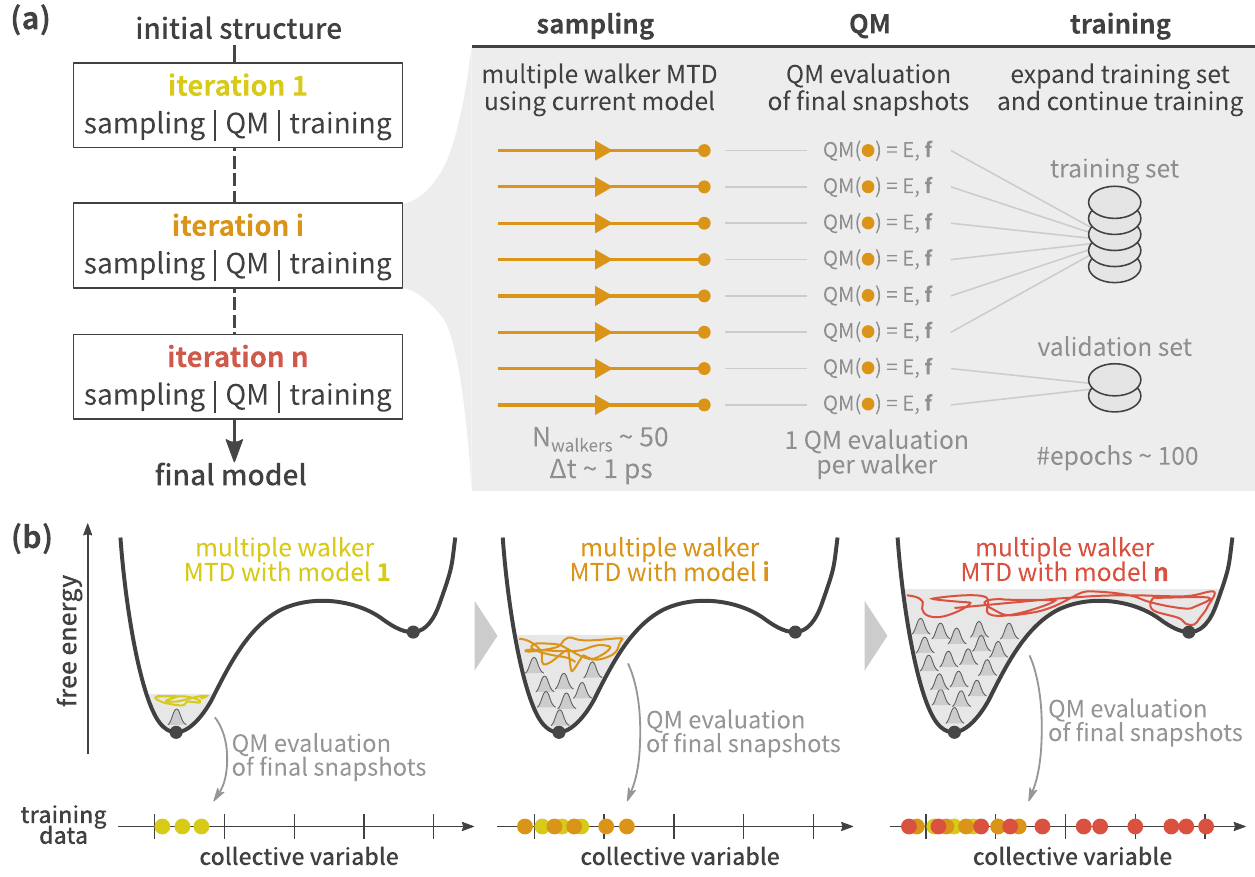
Fig. 2 Overview of the incremental learning approach as a combination of enhanced sampling and on-the- fl y training. a Each iteration employs the current MLP in multiple walker metadynamics to explore increasingly larger regions in phase space, after which the obtained samples are evaluated at the QM level and the MLP is retrained. b Metastable regions and transition paths are automatically explored and included in the training